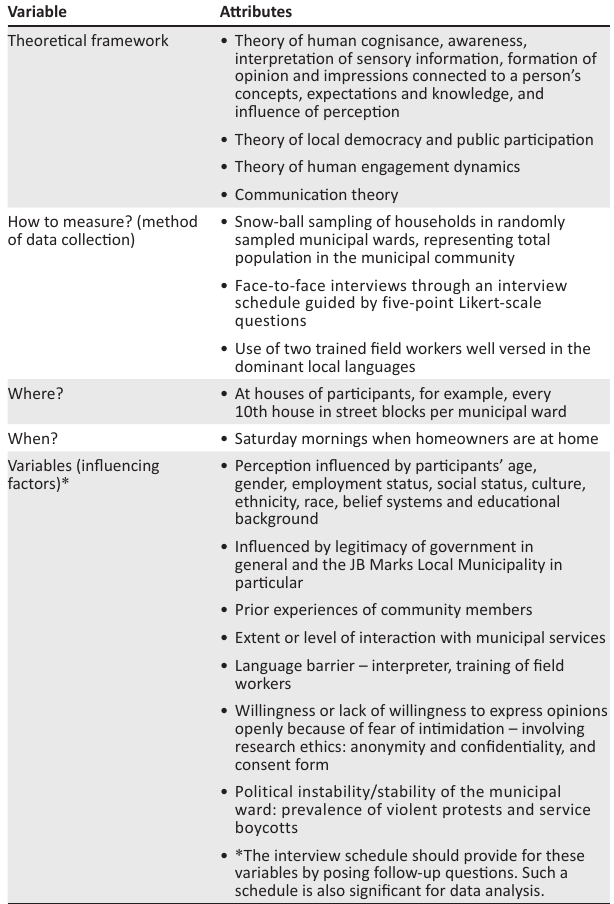
TABLE 4: Framing concept 4 – Perception. 1